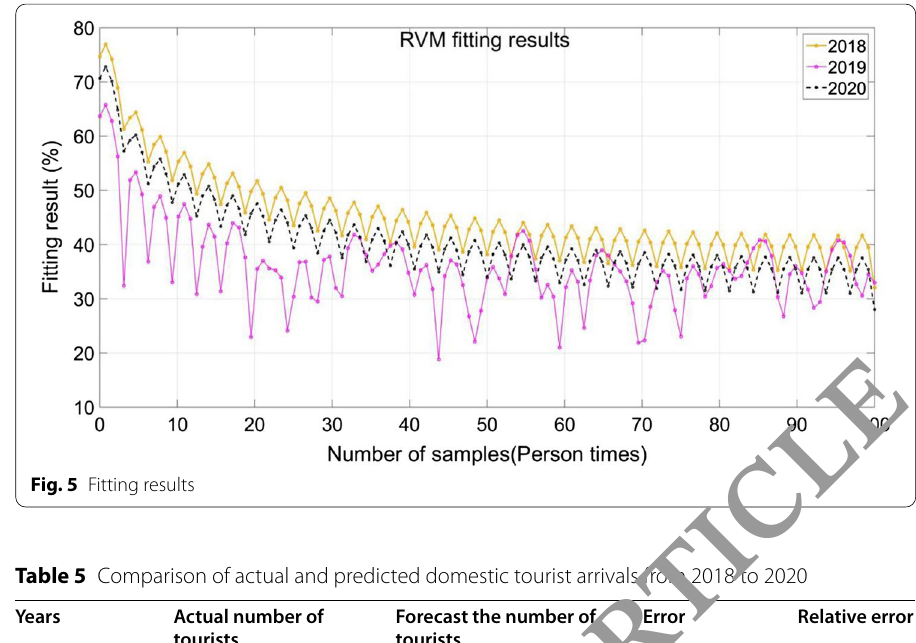
Fig. 5 Fitting results